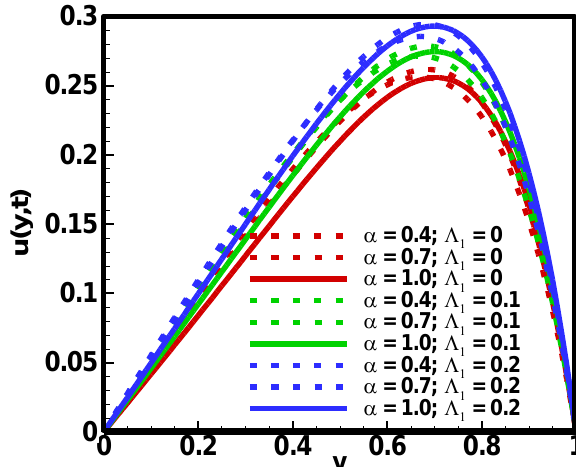
= 0.1, Pr = 21, 𝛽 = 0.1, 𝑃𝑟 =21,𝐾 2 1 = 2